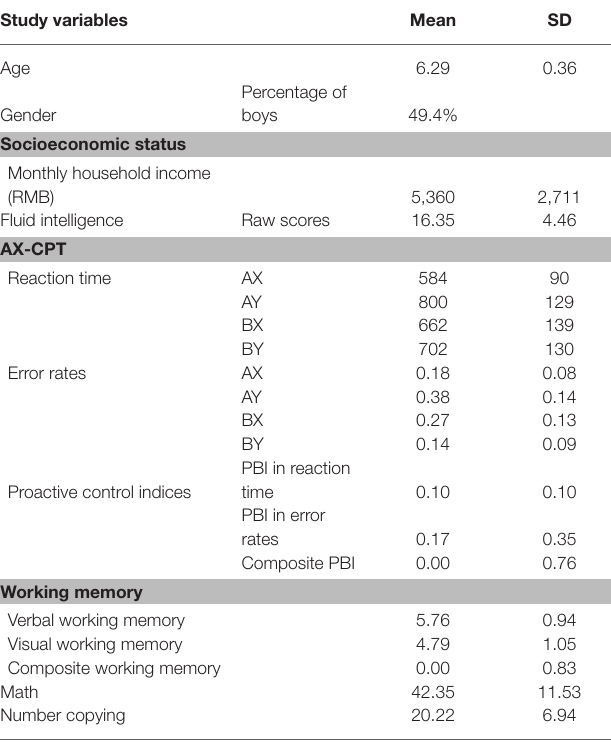
TABLE 1 | Mean (SD) and range of all the study variables ( N =